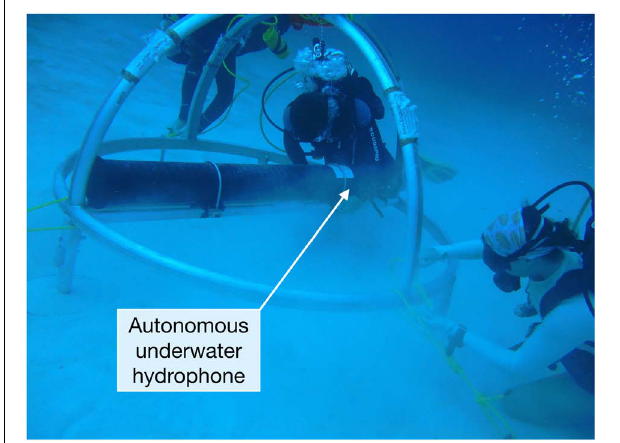
FIGURE 2 | Divers deploying the Virgin Islands instrument. The instruments for all of the moorings used here consist of an acoustic data logging system housed in a composite pressure case and secured to a bottom-mounted metal frame (Photograph: Clayton Pollock/NPS, Virgin